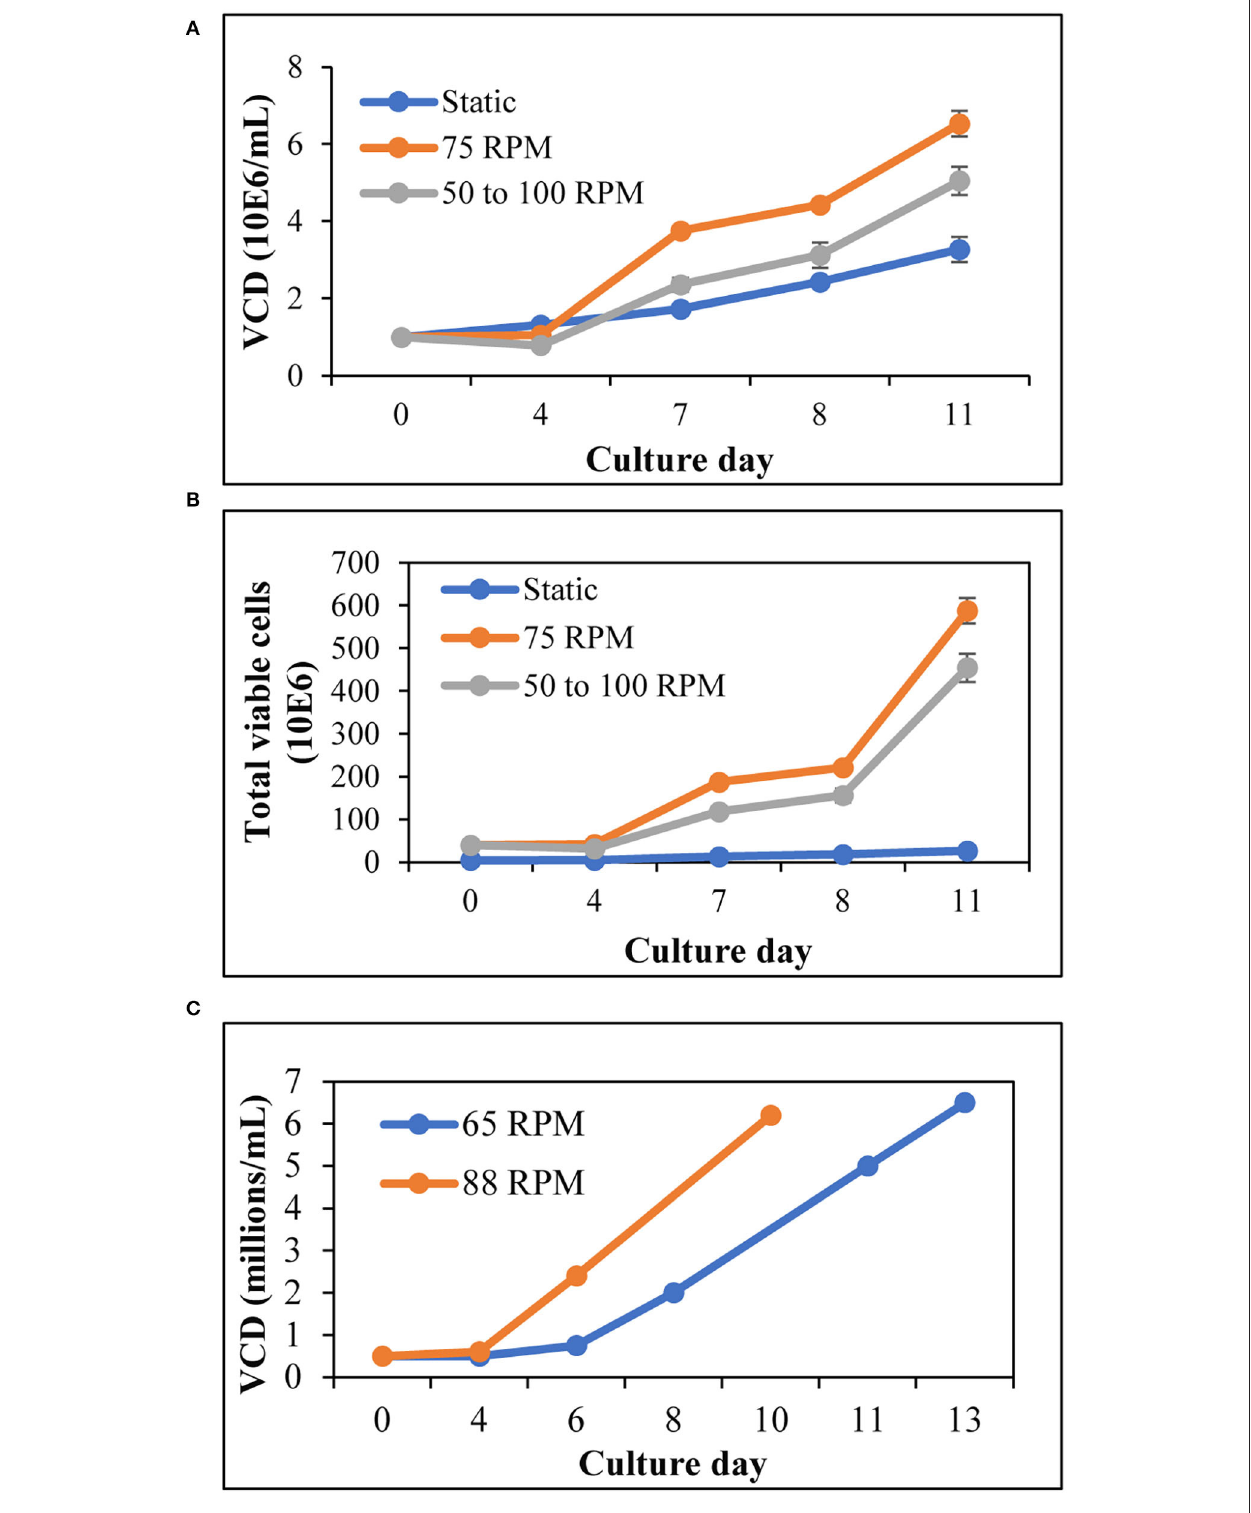
FIGURE 1 | T cells expand better in agitation, compared to 2D flasks: (A) Viable cell density of T cells for 11 days expansion in 125-mL spinner flasks and T25 (2D) flask. The agitation was increased from 50 to 100 RPM on day 5; (B) Total number of T cells during expansion in 125mL spinner flasks and T25 (2D) flask, as evaluated on specified days till day 11; (C) VCD of T cells expanded in 1-L STR at different agitation rates. The values represent mean ± S.E. of three experiments.